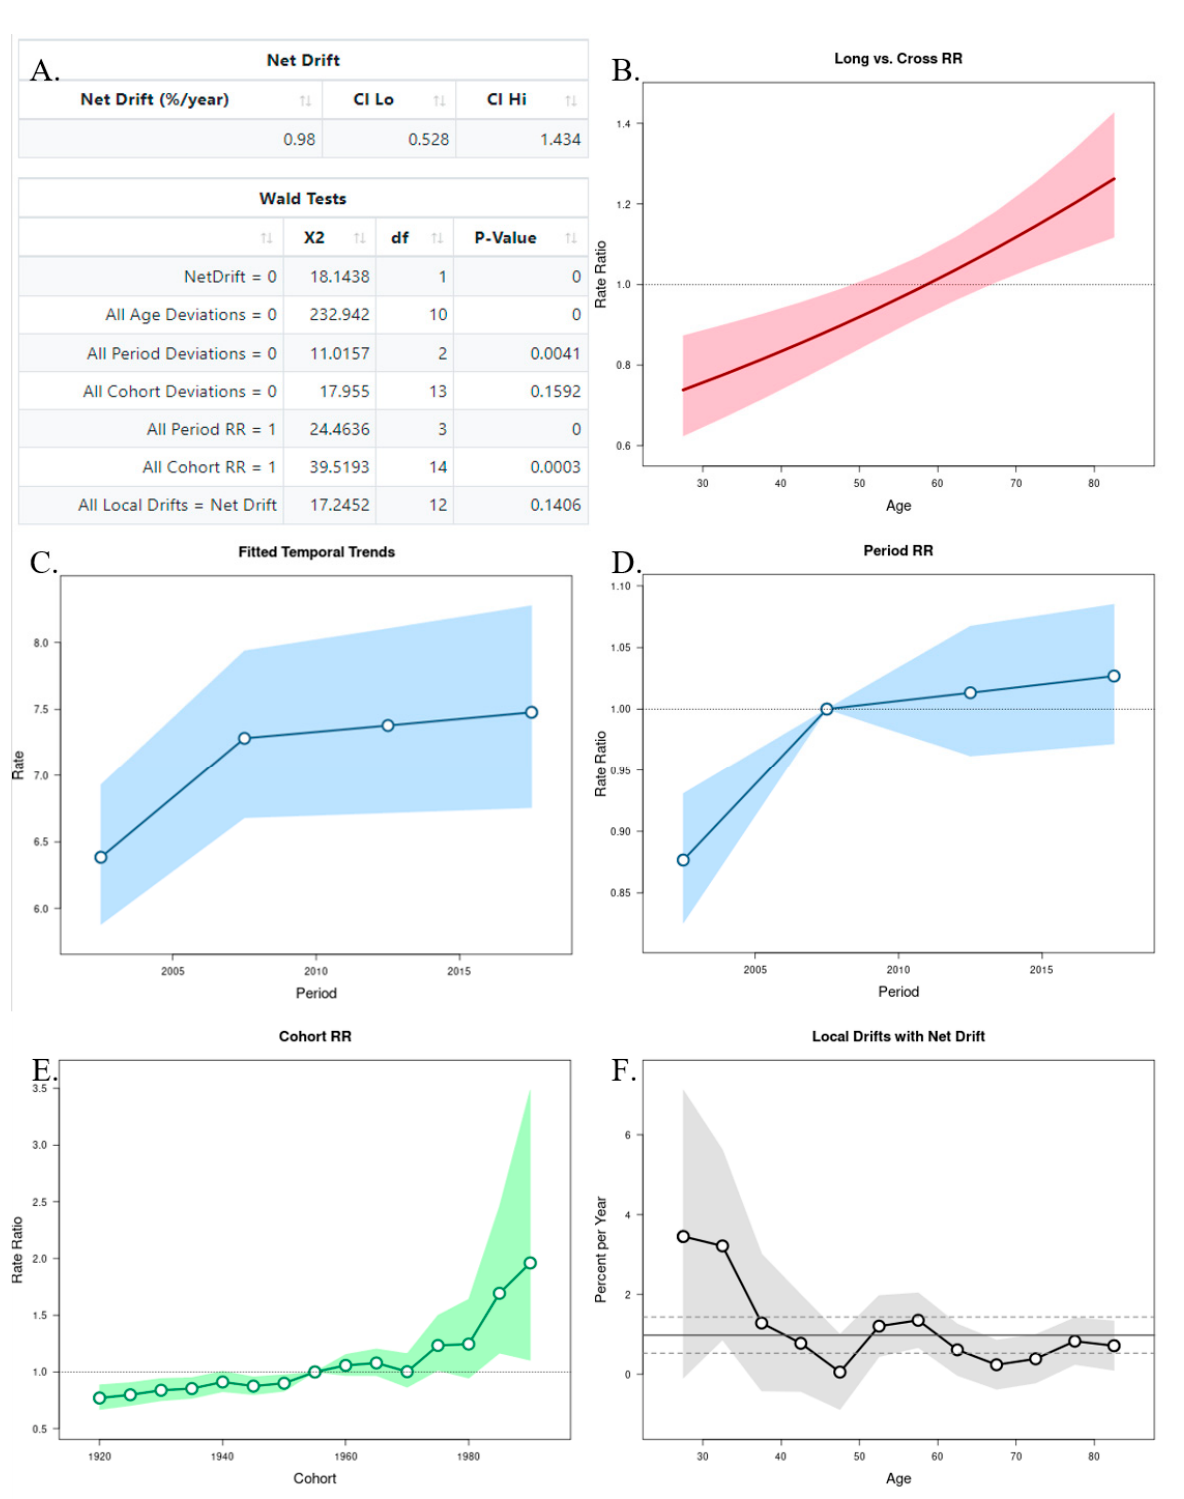
Figure 6. Age–Period–Cohort (APC) analysis with Wald test ( A ), representation of the age ( B ), period ( C , D ), and cohort effects ( E , F ) in females.